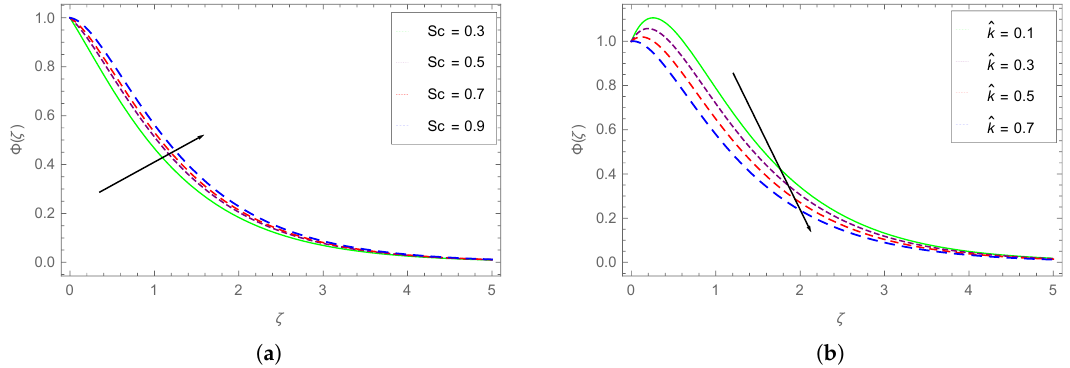
Figure 17. Impact of ( a ) Sc on Φ ( ζ ) and ( b ) ˆ k on Φ ( ζ ) .